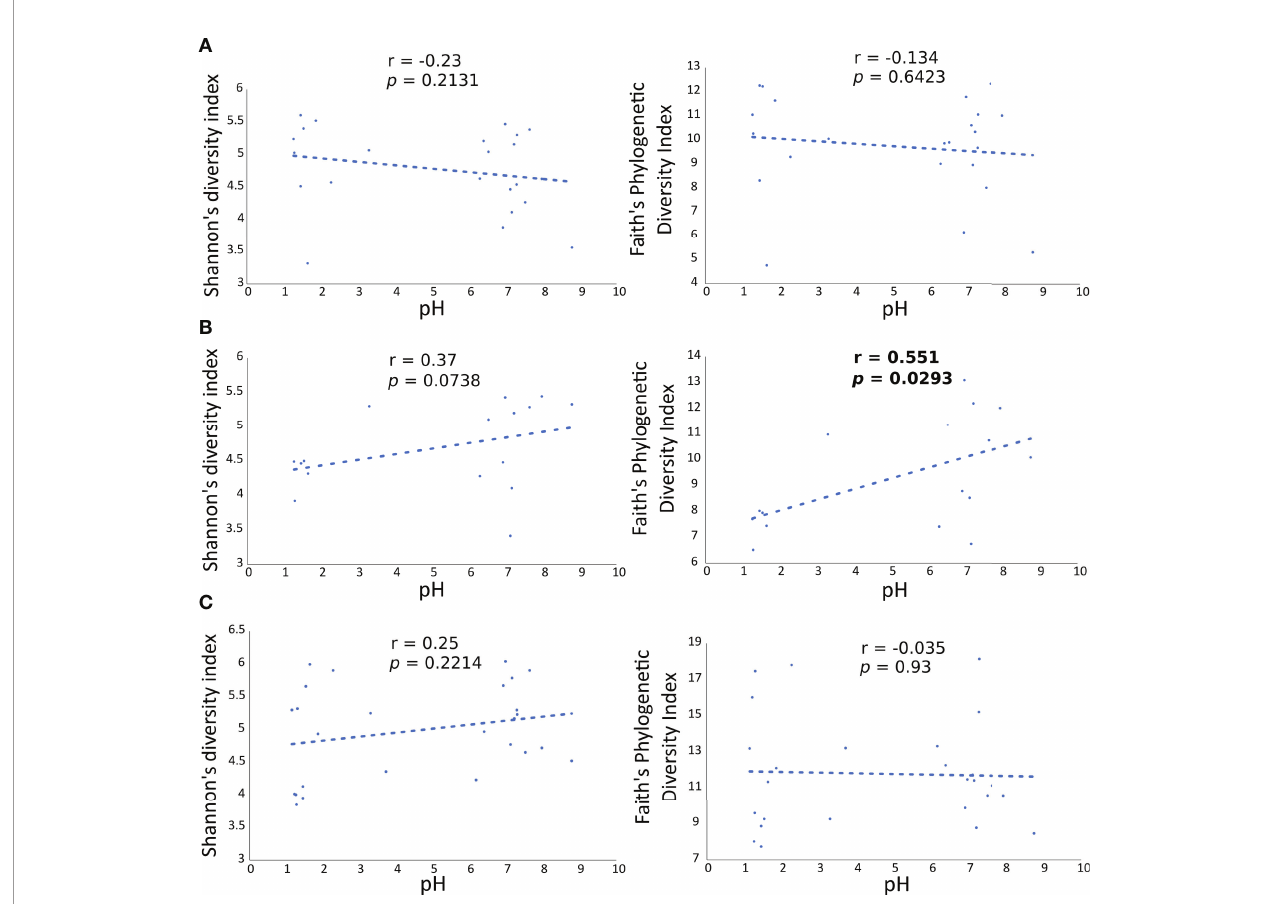
FIGURE 5 | Correlation of Faith ’ s PD diversity index with pH values in all patients at each anatomical site. Each dot is the gastric (A) duodenal (B) and faecal (C) microbiota of a patient, represented as alpha diversity on the y axes, related to the respective pH value, on the x